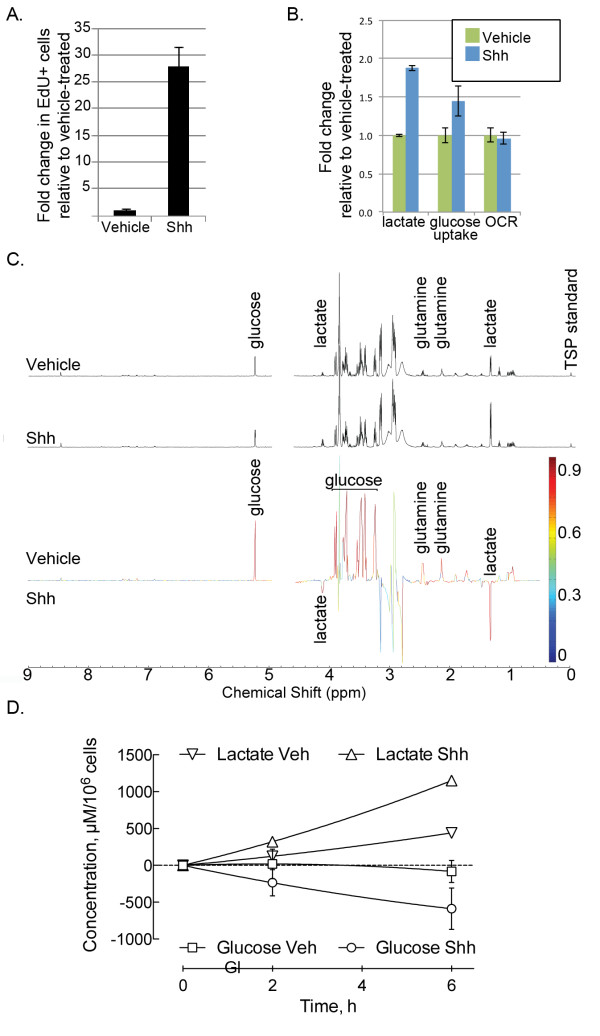
Shh induces aerobic glycolysis in CGNPs. (A) Counts of EdU+ cells, in 3 replicate wells for each condition, confirm that Shh-treated CGNPs continue proliferation after 48 hours in culture, while vehicle-treated CGNPs exit the cell cycle. (B) Lactate production, glucose uptake and oxygen consumption rate (OCR) of Shh-treated and vehicle-treated CGNPs are compared, using 3 replicate wells per condition. Measured values were normalized for cell number and expressed as fold-change relative to vehicle-treated values. Shh increased lactate production (P < 0.01) and glucose uptake (P < 0.03) while no statistically significant effect on the OCR was detected. (C) NMR spectra (representative examples on top; below is orthogonal partial least squares discriminant analysis comparison of 6 replicates of each condition) demonstrate differential accumulation of lactate in media of Shh-treated CGNPs compared with vehicle-treated CGNPs. The loading coefficient is plotted as the y value, and the P scaled correlation coefficient is color-coded as indicated. Lactate peaks are deflected toward Shh, indicating greater value in Shh-treated wells, and color-coded red, indicating statistical significance. (D) Starting with fresh media at time 0, Shh-treated CGNPs used more glucose (P < 0.001) and produced more lactate (P < 0.001) than vehicle-treated CGNPs over a 6-hour period. Importantly, in Shh-treated CGNPs, glucose utilization and lactate production were in a stoichiometric 1:2 ratio. Graphs present mean ± standard error of the mean (SEM). Two-tailed Student’s t test was used for statistical comparisons in (A) and (B), while two-way analysis of variance with Bonferroni correction was used in (D).